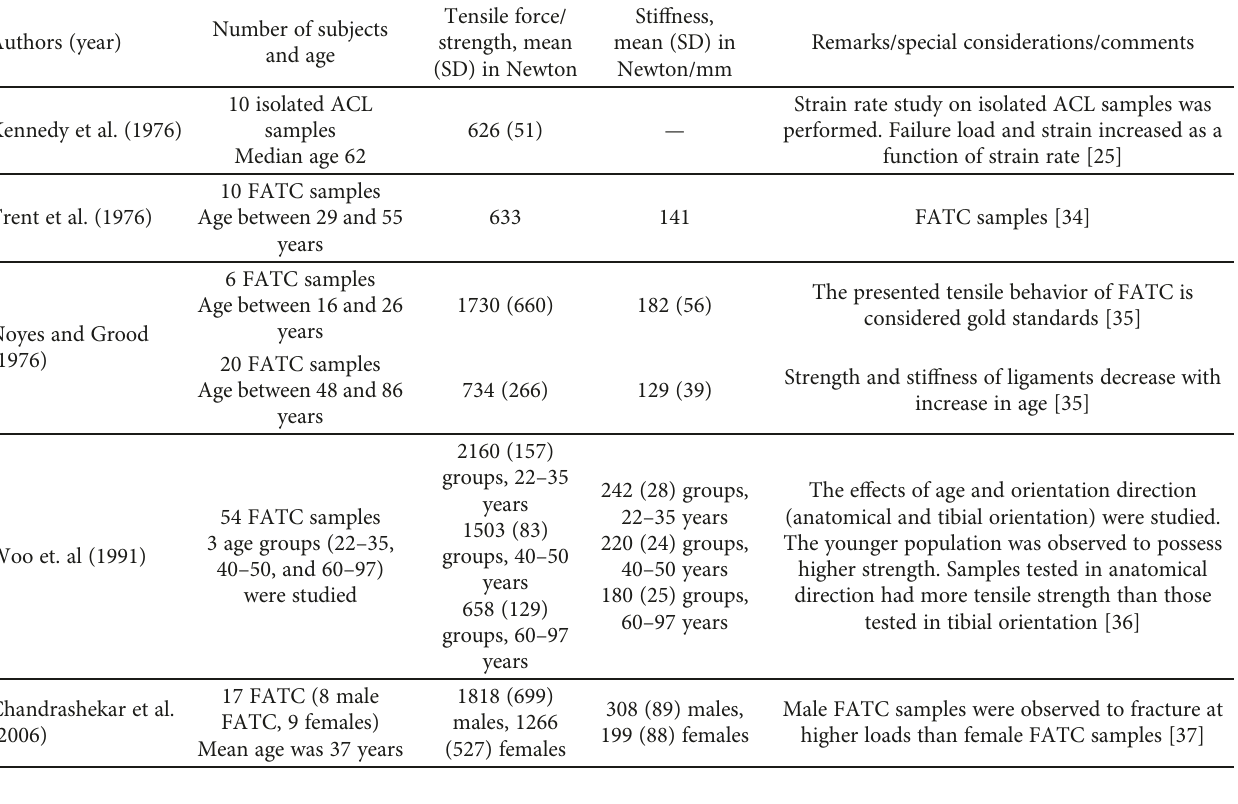
Table 1: Human cadaveric studies on mechanical characterization of ACL and FATC.